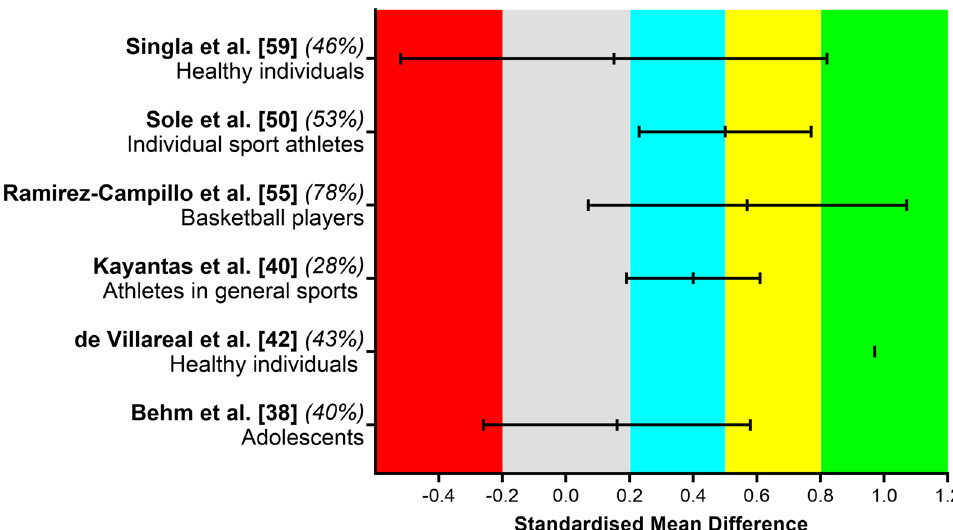
Fig. 4 Summary of standardized mean difference and 95% confidence intervals reported in meta‑analyses comparing the baseline to post‑plyometric training changes on muscular strength performance. Author name and year are followed by the quality of the studies score ranked by AMSTAR 2. Positive values represent improved performance effects and negative values detrimental effects. Each colored area represents a different magnitude of effect: gray trivial, blue small, yellow moderate, and green large effects, while the red area represents detrimental = = = = effects. De Villareal et al. [42] did not clearly describe the 95% confidence interval; thus, we only reported standardized mean difference